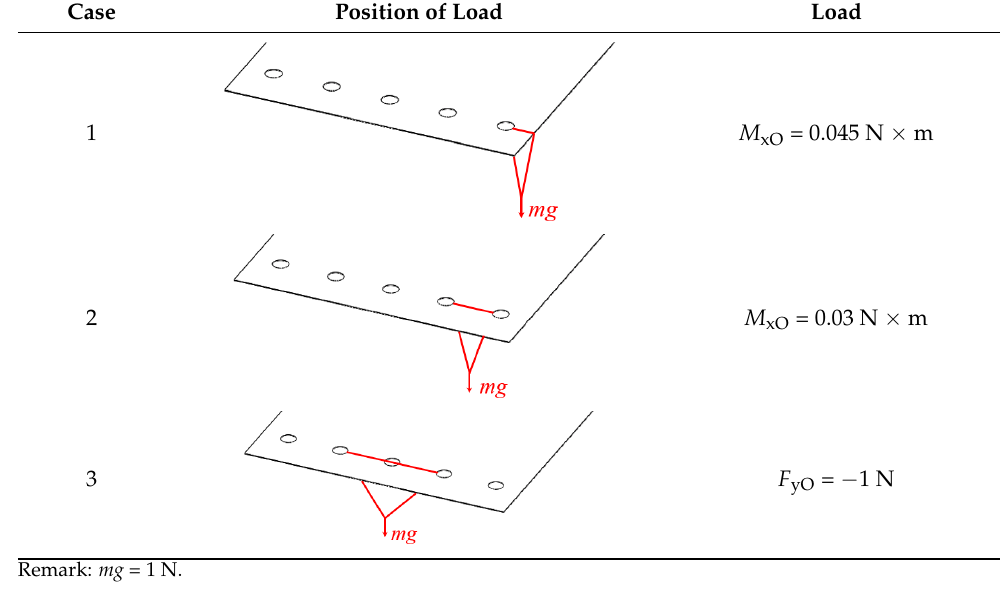
Figure 13. The finite element mesh of the FLS model. Table 7. Theoretical and simulation results of the displacement and rotation angle of points ( P 1 , P 2 , P 3 ).